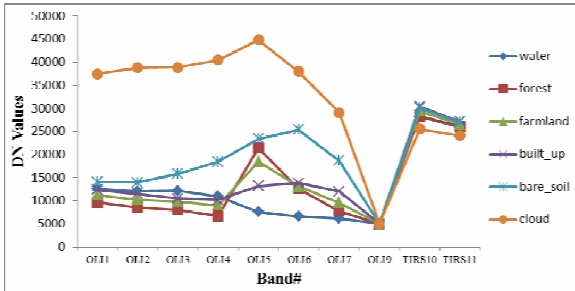
Figure 2. Spectral profiles of six typical land covers in the study area